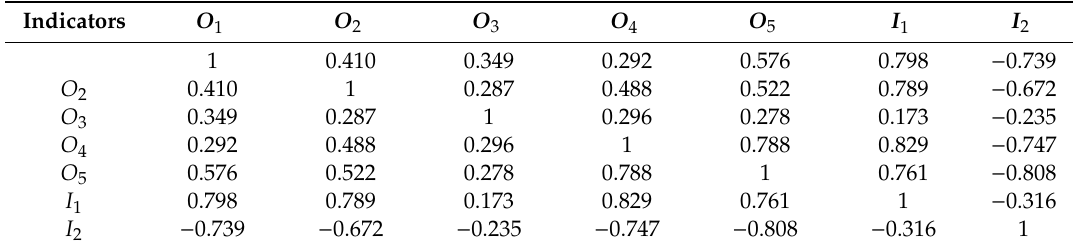
Table A2. Correlation coe ffi cients of input and output indicators in the e ffi ciency measurement of fiscal policies for environmental pollution control.